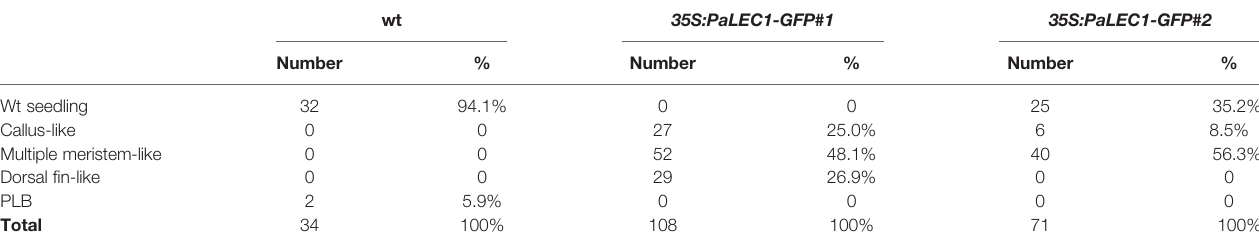
TABLE 1 | Different types of structures were formed from germinating protocorms of 35S:PaLEC1-GFP transgenic lines. Number of the represented type (number) and percentage of the represented type (%) of structures are shown.